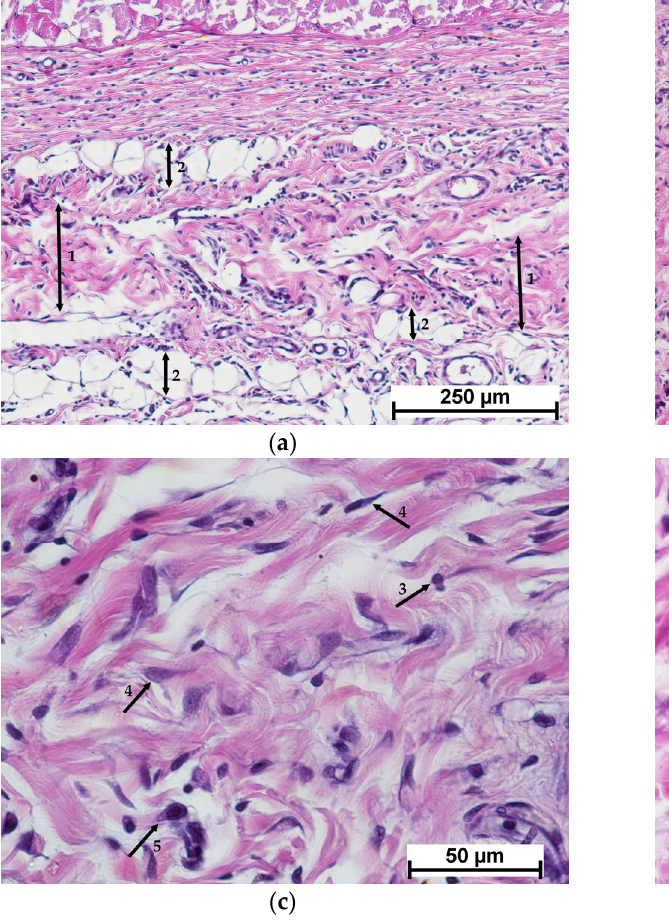
Figure 9. Histological picture—day 14. Comparison of cell-containing scaffold ( a , c ) and cell- containing collagen matrix ( b , d ). ( a , b )—implant site, general view, ( c , d )—connective tissue structure at the implantation site. Staining with hematoxylin–eosin. Note: (1)—connective tissue; (2)—adipose tissue; (3)—lymphocyte; (4)—fibroblast; (5)—macrophage; (6)—mast cell.